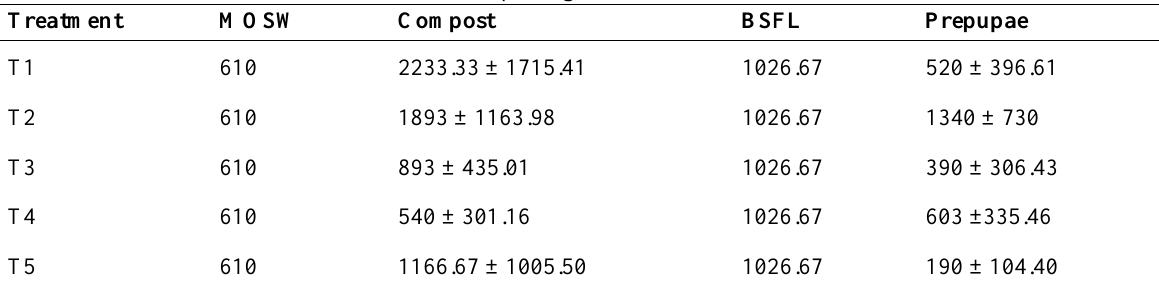
Table 8 Escherichia coli population in BSFL compost Treatment MOSW Compost